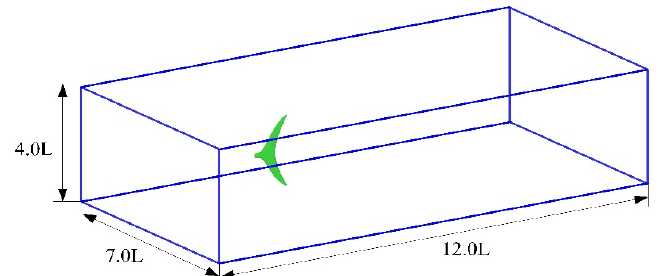
Figure 3. Grids of caudal fin.